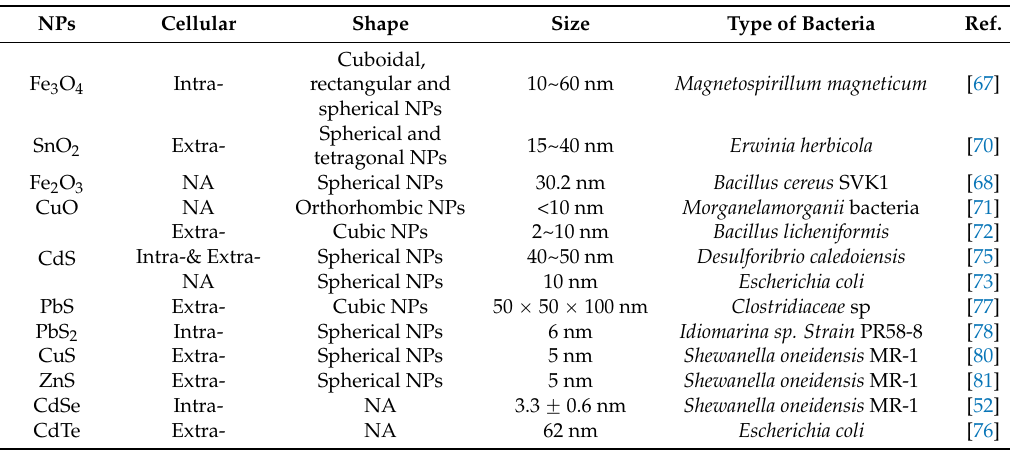
Table 2. Compounds synthesized by